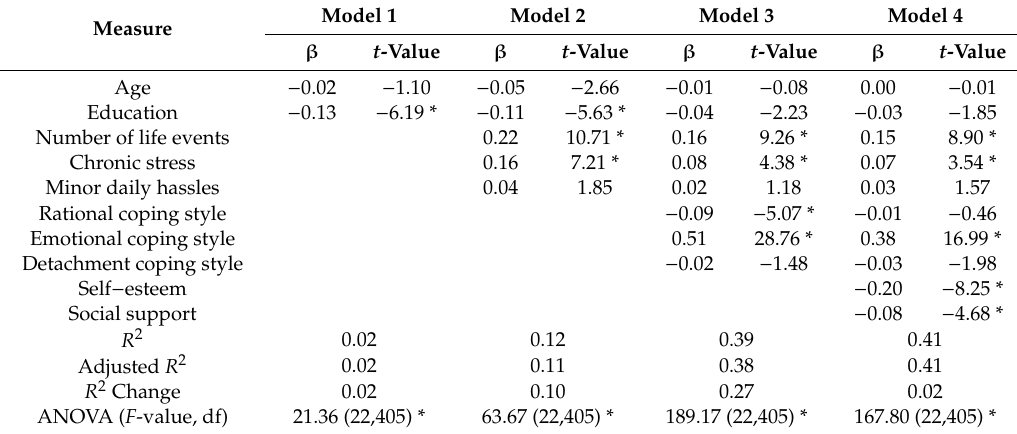
Table 4. Summary of the hierarchical regression with the psychological distress as the dependent variable for the